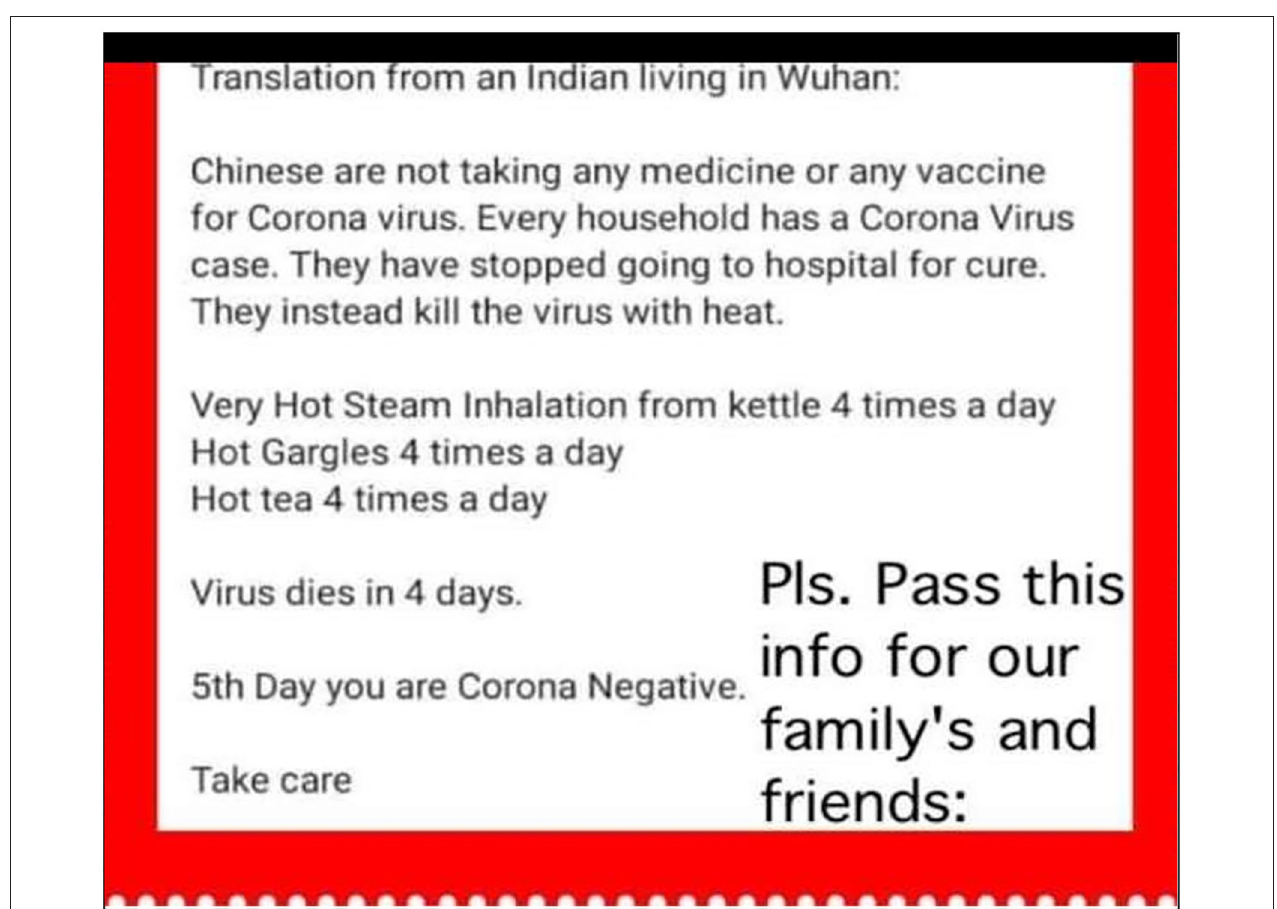
FIGURE 3 | Misconception about protective effect of steam